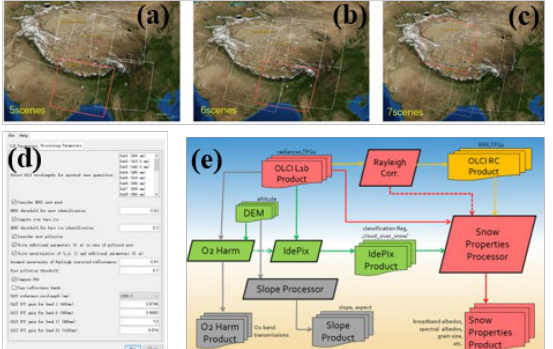
Figure 2. (a)(b)(c) Sentinel-3 images cover the High Asian region. (d) SPP software interface(ESA,2021.). (e) Inverse flow chart.( SEOM S3 for Snow Soft User Manual,